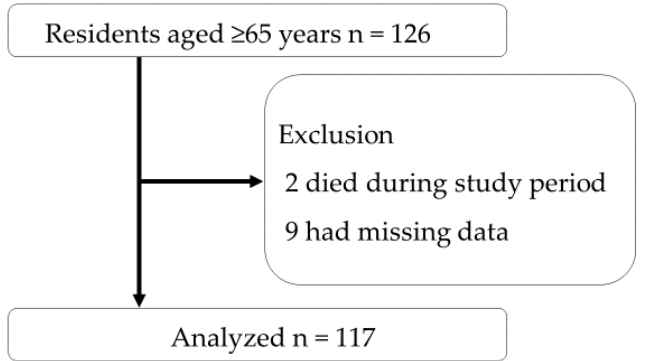
Figure 1. Flowchart of the study participants. The study analyzed 117 participants.